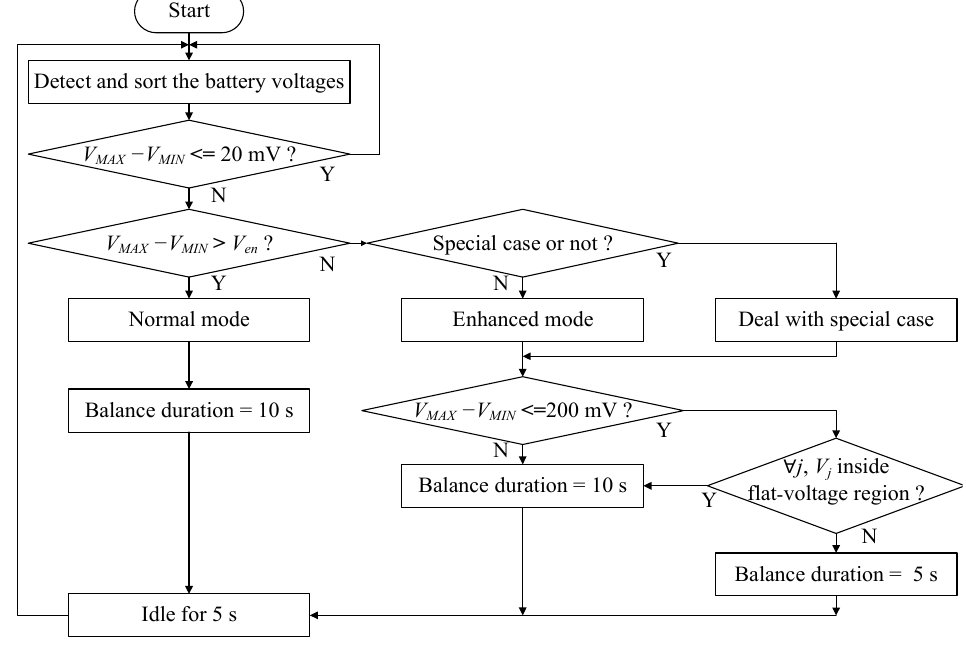
Figure 7. Flowchart for the balance strategy.